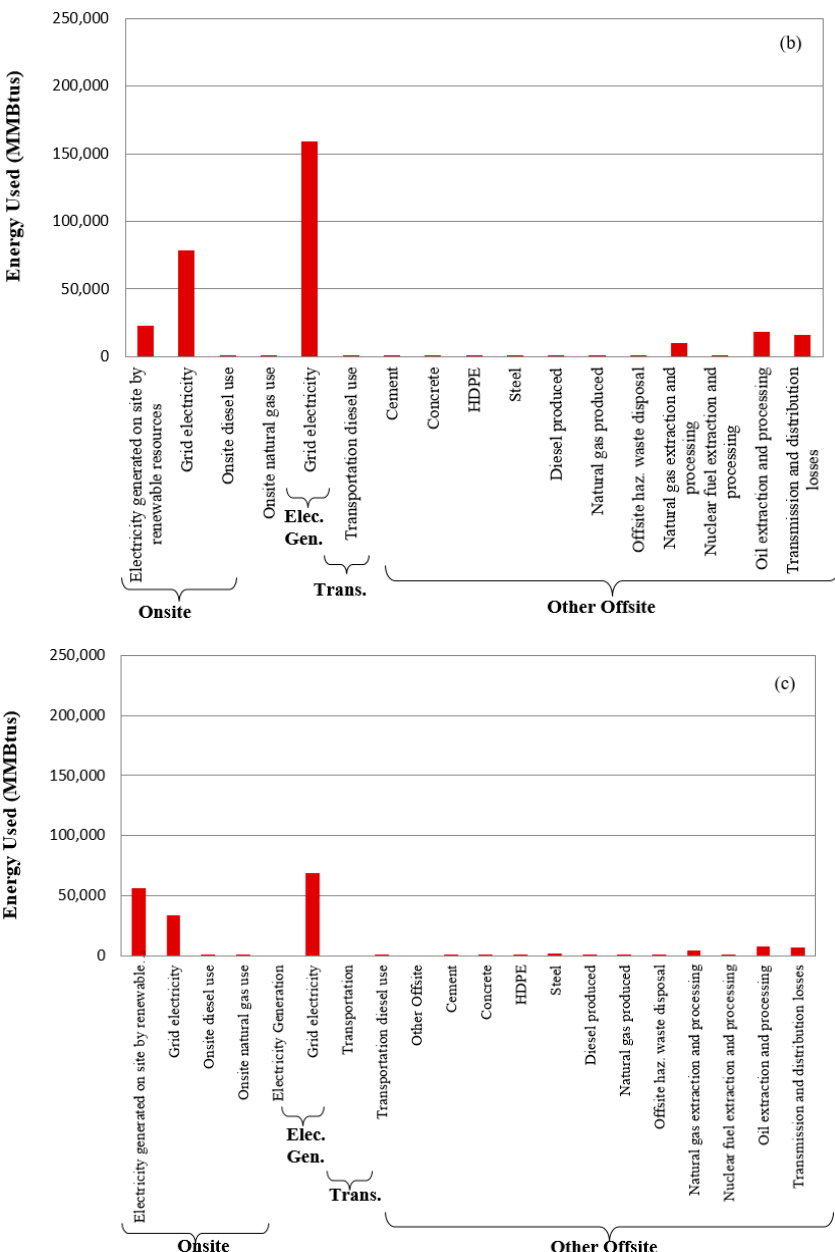
Figure 5. Contributors to the total energy used metric; ( a ) Scenario 1, ( b ) Scenario 2 and ( c ) Scenario 3 .